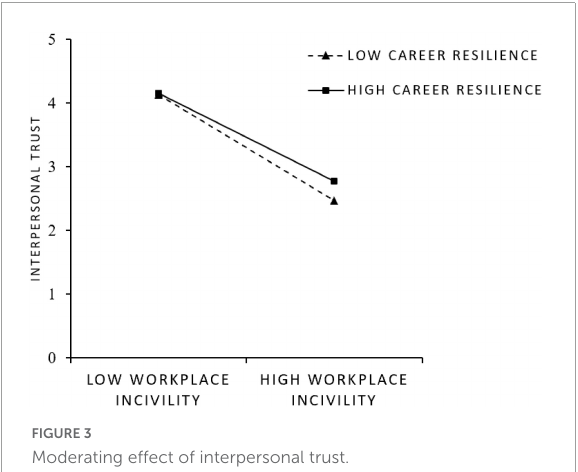
FIGURE3 Moderating effect of interpersonal